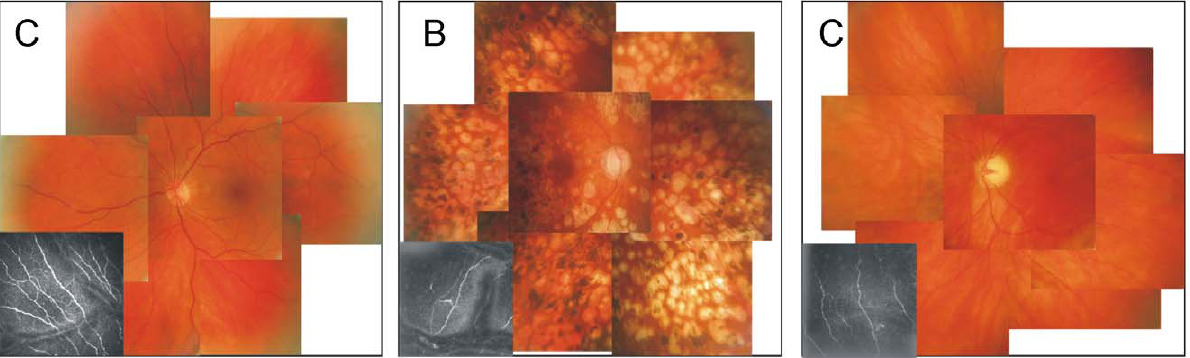
Figure 1. Seven standard-field fundus photography with corresponding CLSM images. Regular SBP pattern and normal fundus appearance in control (A). Patches of retinal whitening and rarefication of nerve fibers in SBP in a patient with DR (B). Relatively impaired appearance of SBP in a patient without DR (C). doi:10.1371/journal.pone.0052157.g001 PLOS ONE |